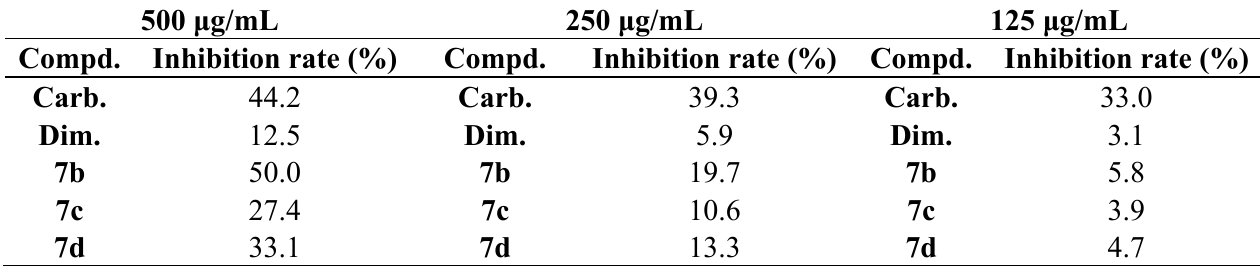
Table 4. The inhibition rates to Fusarium oxisporum f. sp.